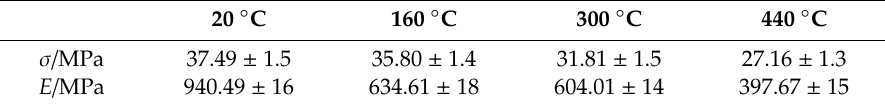
Figure 6. Flatwise compressive stress versus strain curves of the unvented honeycomb sandwich panels. Table 4. Flatwise compression properties of the unvented honeycomb sandwich panels.